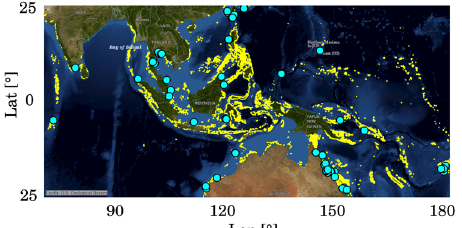
Fig. 1 The CT and Indian Ocean study area, with superposed coral reef and spawning locations. In yellow the distribution of coral reefs in